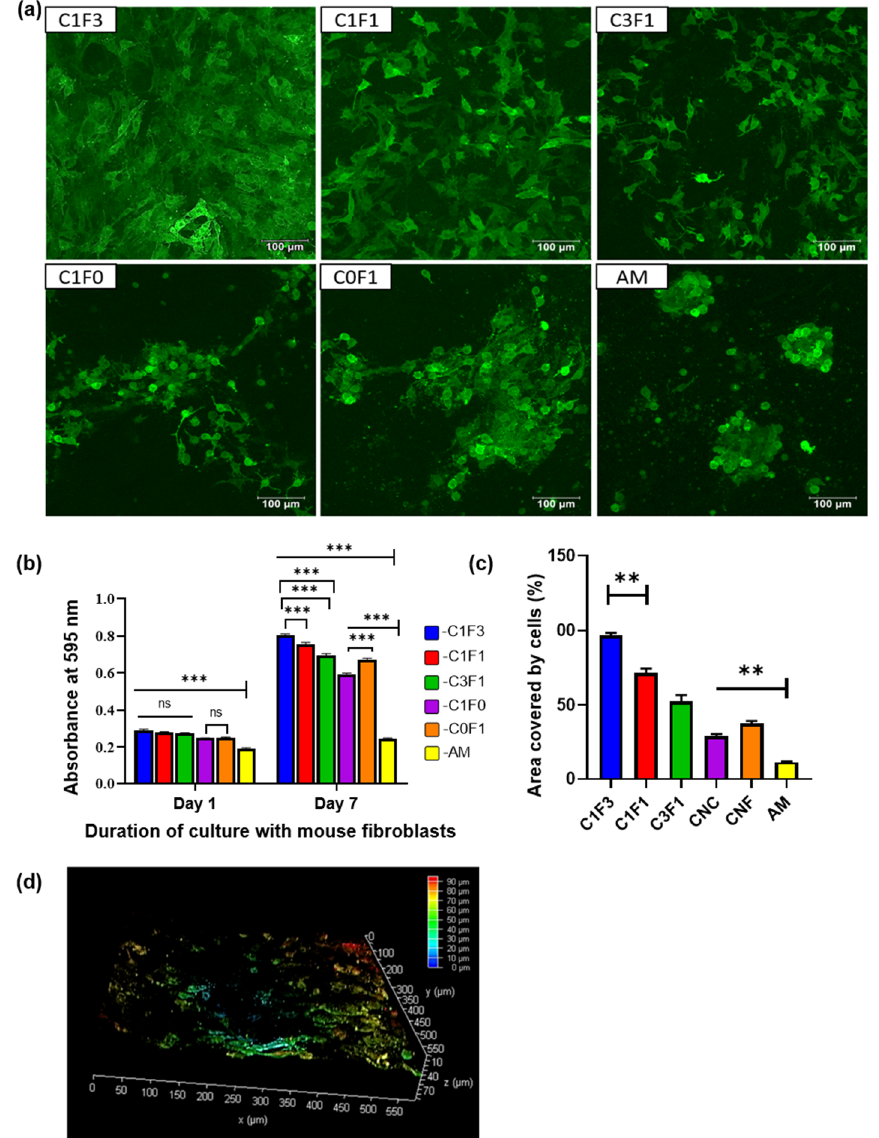
Figure 10. Cytocompatibility of CNC–CNF and acrylamide-based hydrogels with mouse fibroblasts, 3T3s (transfected with GFP). ( a ) Confocal micrographs taken after culturing 3T3s-GFP onto the hydrogels for a week. The images are representative images of overlapped z-sections. ( b ) Confocal image for sample C1F3 represented in 3D view depicting the depth coverage by the cells. ( c ) Area covered by cells in individual hydrogels calculated from the confocal images using ImageJ. Statistical analysis was performed by the Tukey test, where ** represents p < 0.001 (n = 3). ( d ) Estimation of cellular proliferation and viability determined by the MTT assay with cell-laden hydrogels after day 1 and day 7 of culture with mouse fibroblasts. Statistical analysis performed by 2-way ANOVA, where *** and ns represent p < 0.001, and p = not significant, respectively (n = 3).